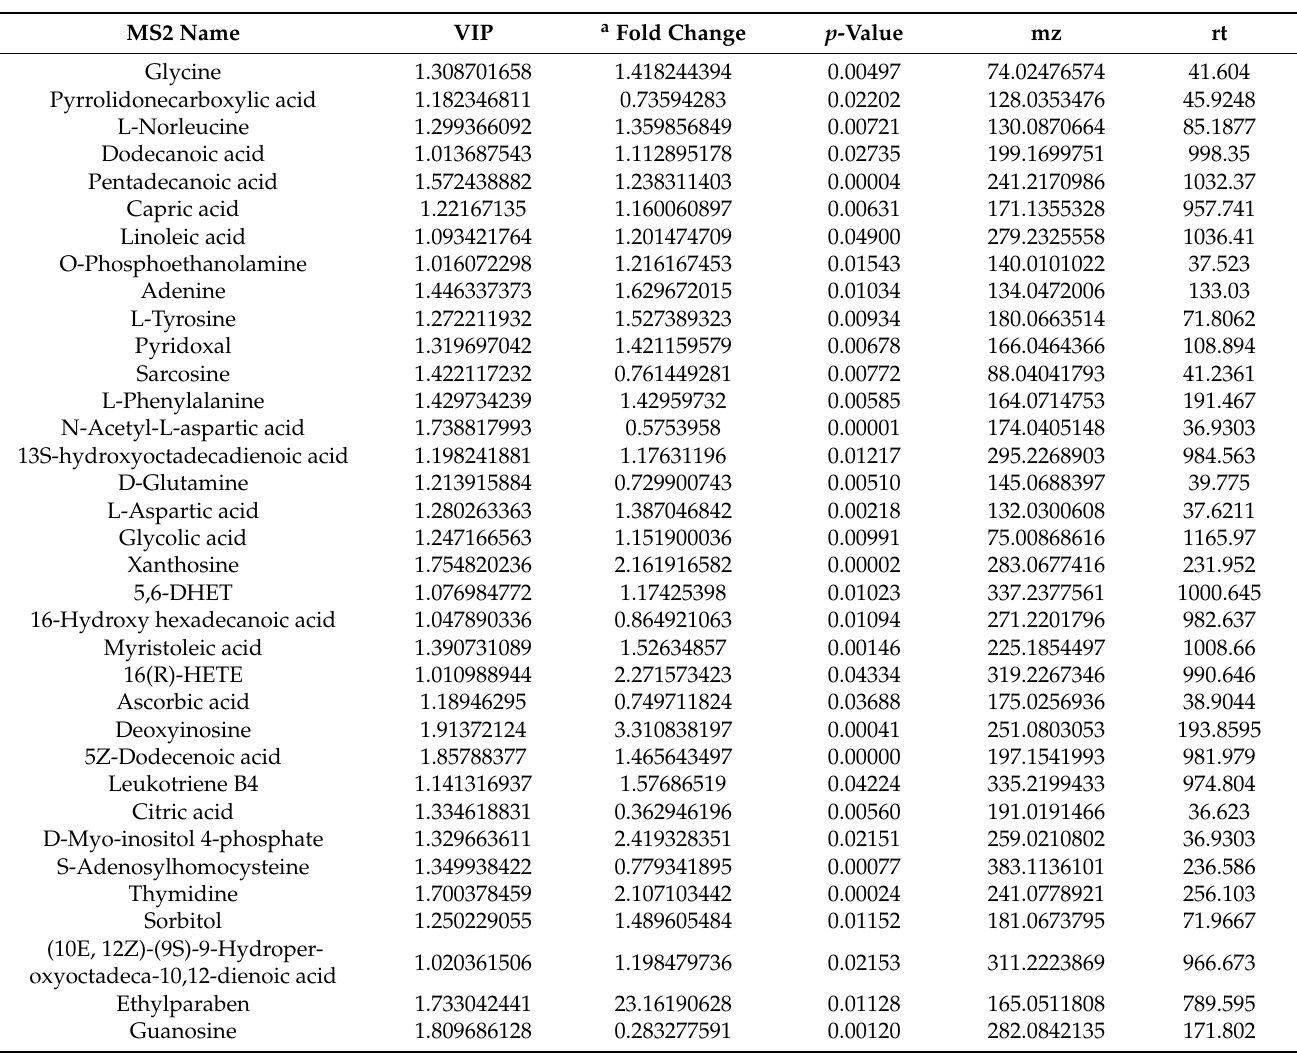
Table 2. Significantly altered metabolites under negative mode by untargeted